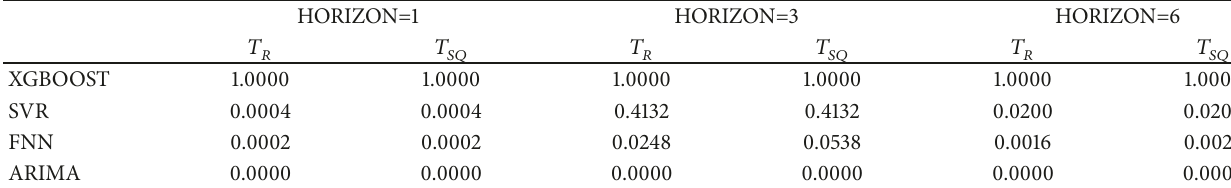
Table 4: MCS between XGBOOST, SVR, FNN, and